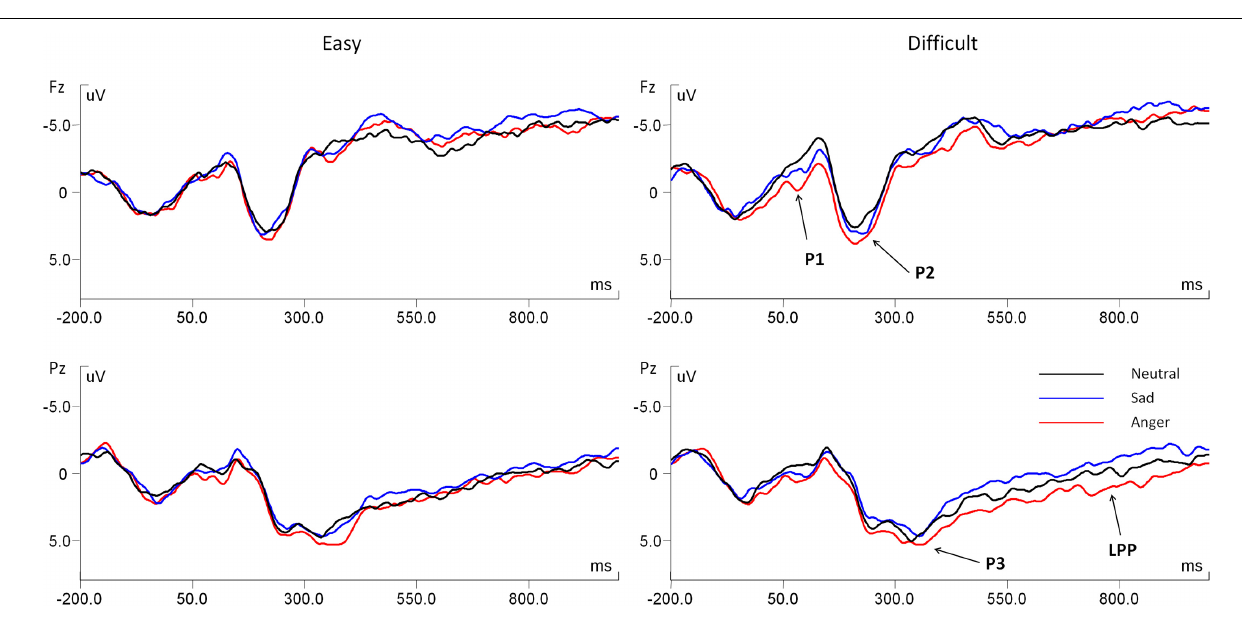
FIGURE 3 | Grand average ERPs during the evaluation stage at Fz and Pz in the anger, sad, and neutral prime conditions for the easy-to-select choices and the difficult-to-select